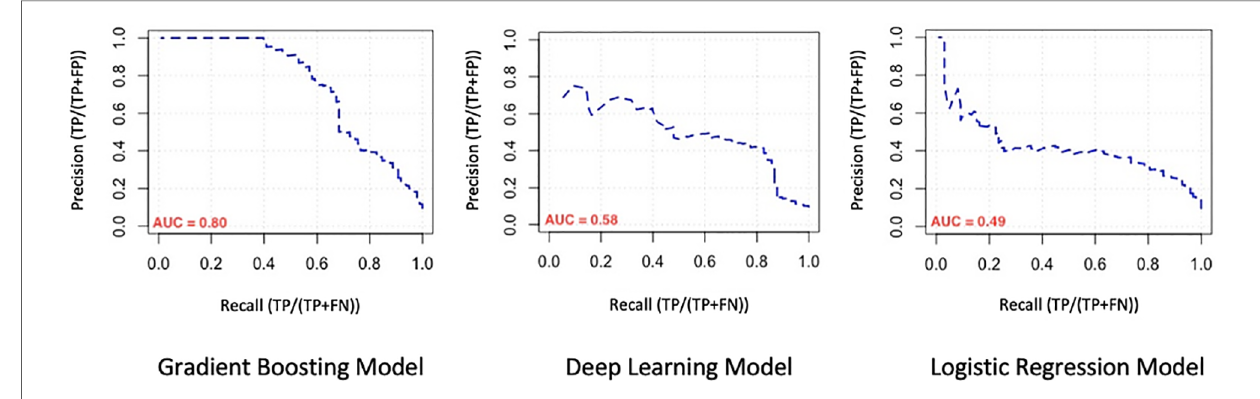
FIGURE 2 Comparison of the precision-recall curve (PR curve) of machine learning models. AUC, area under the